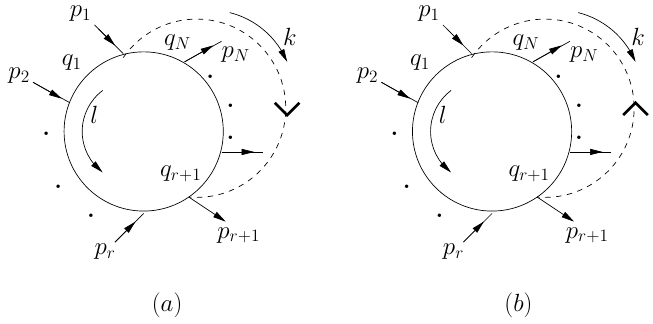
Figure 3 . (a) S-matrix amplitude with ordered pair of vertices entering the BCC equation (see text); (b) the same amplitude with opposite ordering.